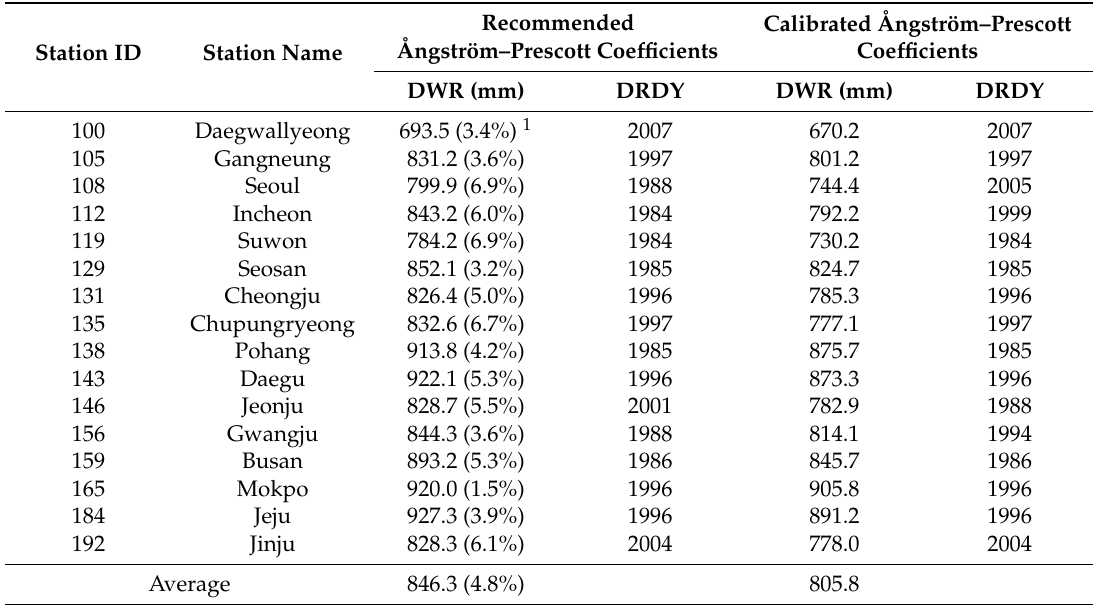
Table 4. The design water requirement (DWR) and drought reference design year (DRDY) for each the study